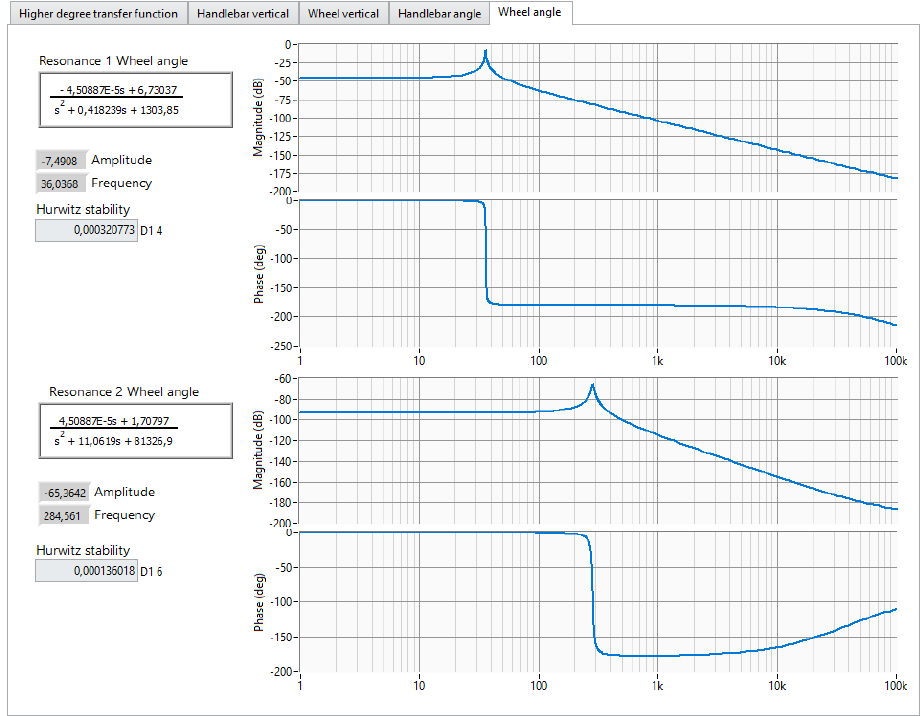
Figure 4. View of the program window for frequency analysis of individual transmittances.